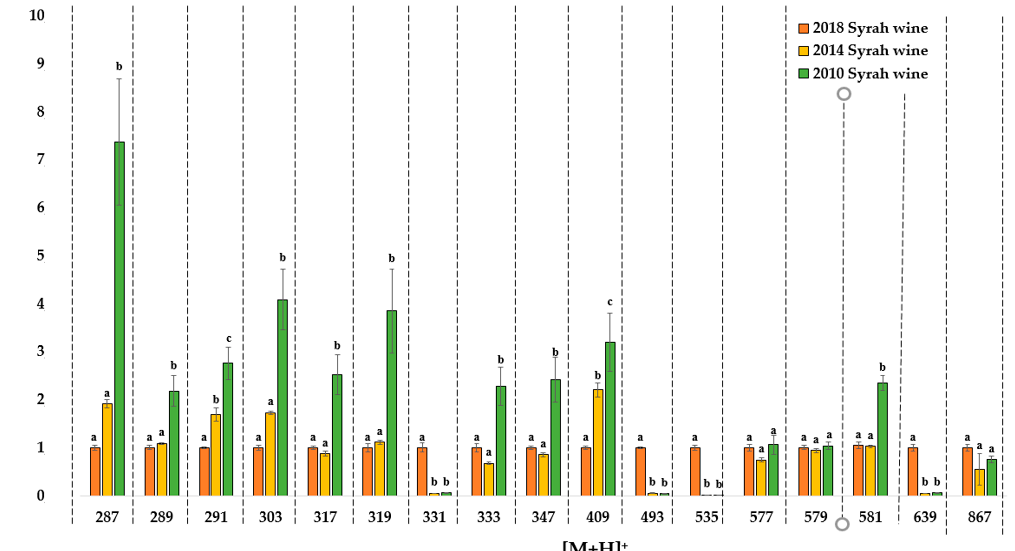
Figure 4. Natural oxidation samples. Ion intensity comparison of high-resolution MS spectra. Intensities for the three wine samples (2018, 2014 and 2010) are given for each [M+H] + ion and normalized compared to the 2018 sample values. Figures are expressed as mean values ( n = 3) with standard deviation. Different letters indicate a significant difference (Tukey test, α = 0.05) between vintages for a same [M+H] + ion.